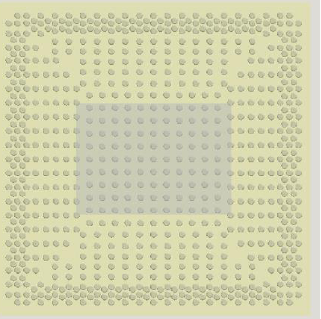
Figure 2. Detail of the solder ball (SAC 305).